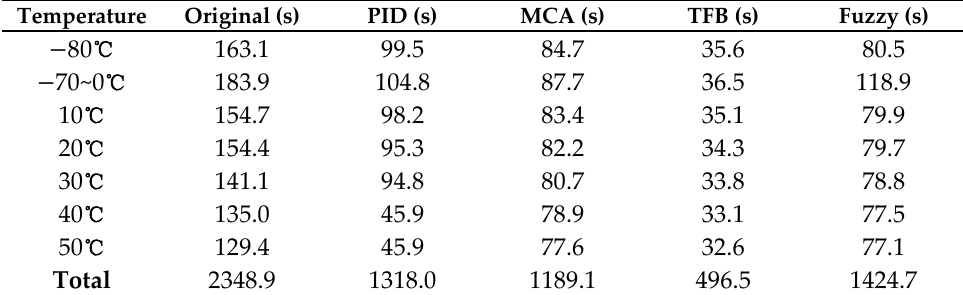
Table 1. Steady -state time of each control method at different temperature